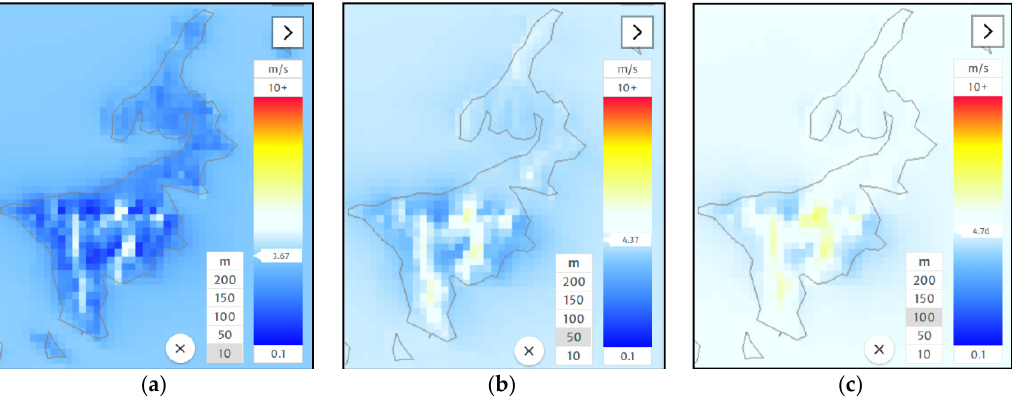
Figure 12. Wind velocity in Indonesia based on Global Wind Altas [43].